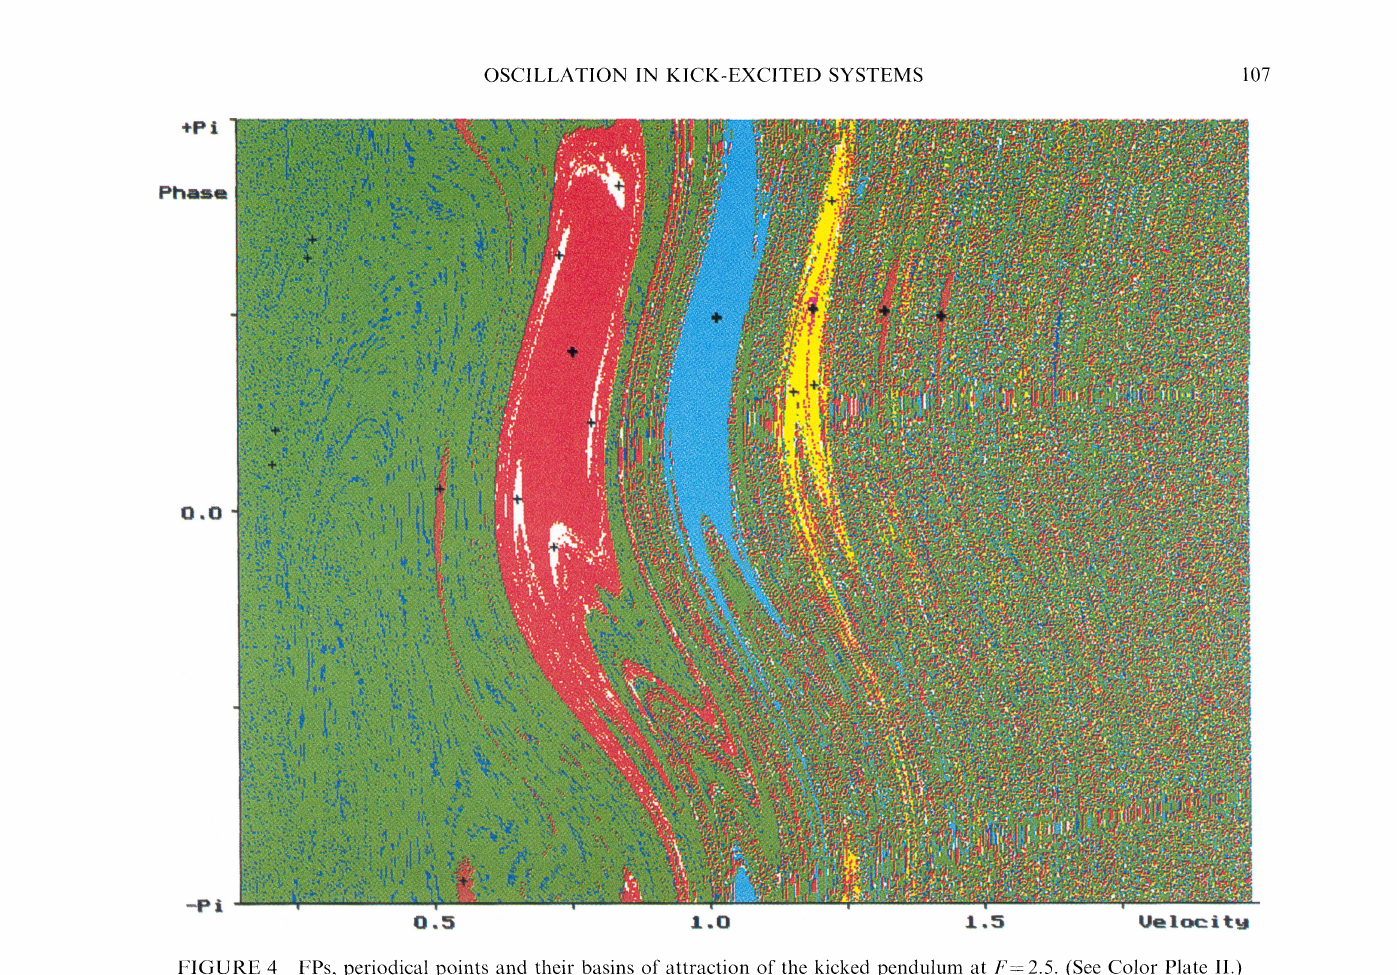
FIGURE 4 FPs, periodical points and their basins of attraction of the kicked pendulum at F= 2.5. (See Color Plate